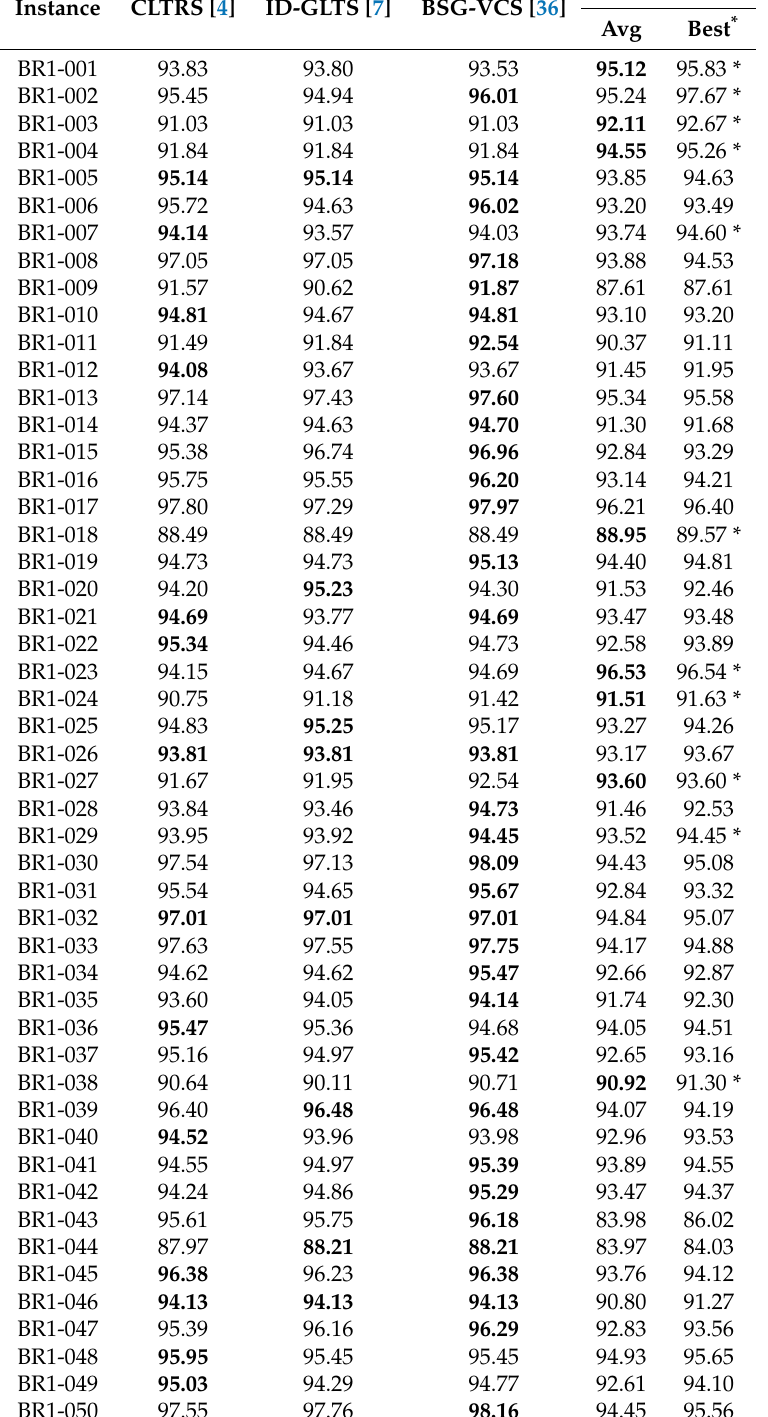
Table 1. Results for group